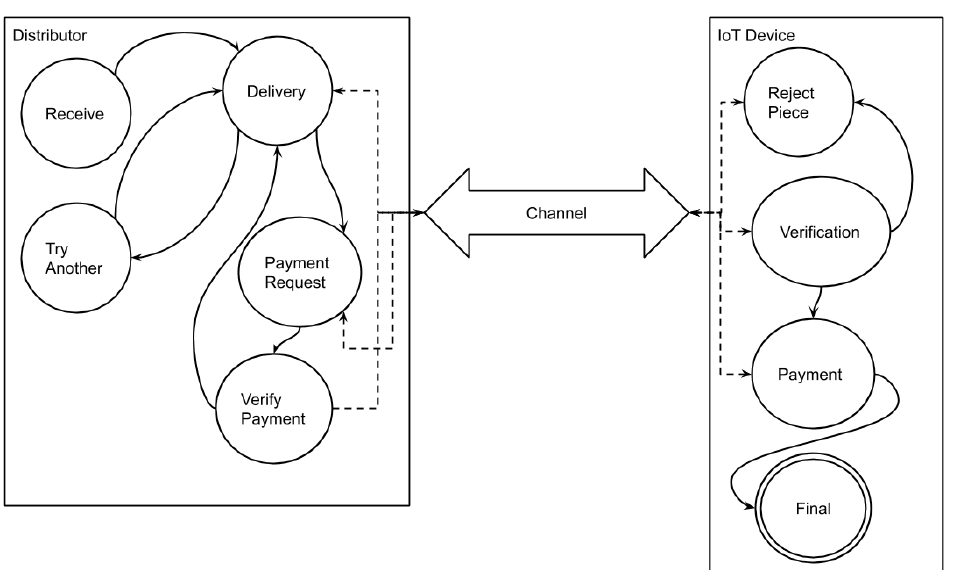
Figure 4. P 4 UIoT state transition